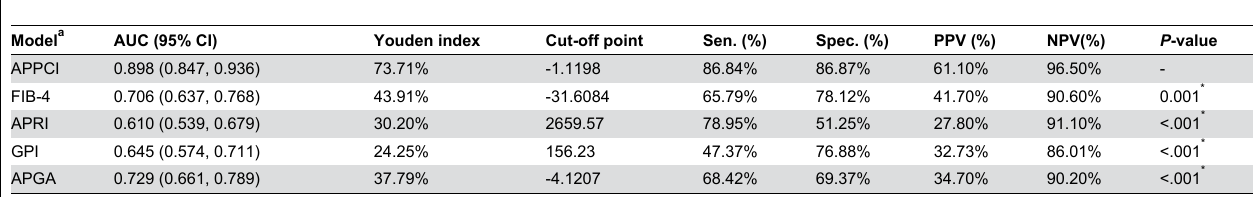
Table 7. Comparisons of different non-invasive models predictive of cirrhosis. (N=198)